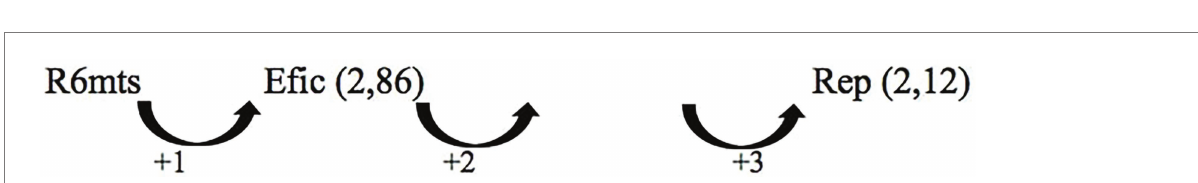
FIGURE 10 Association pattern between the focal conduct shot “R6mts” and the conditioned conduct attack result. “Efic” and opponent response “Rep,” considering game time factor/variable, in all national teams. R6mts, 6 m shot; Efic, goal or 7 m; Rep, throw-off.